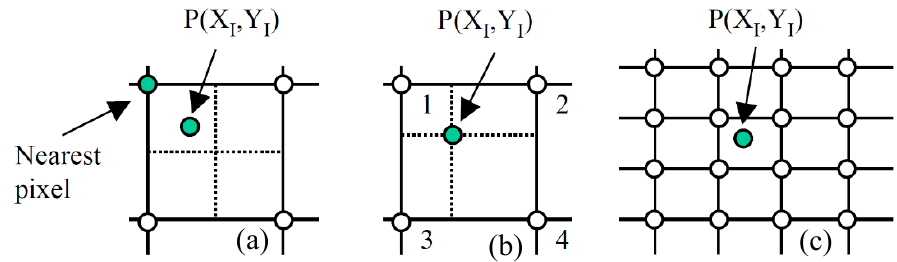
Figure 3. Techniques of resampling: ( a ) nearest neighbour (NN), ( b ) bilinear interpolation (BI) and ( c ) cubic convolution (CC). Table 3. Various types of resampling techniques.